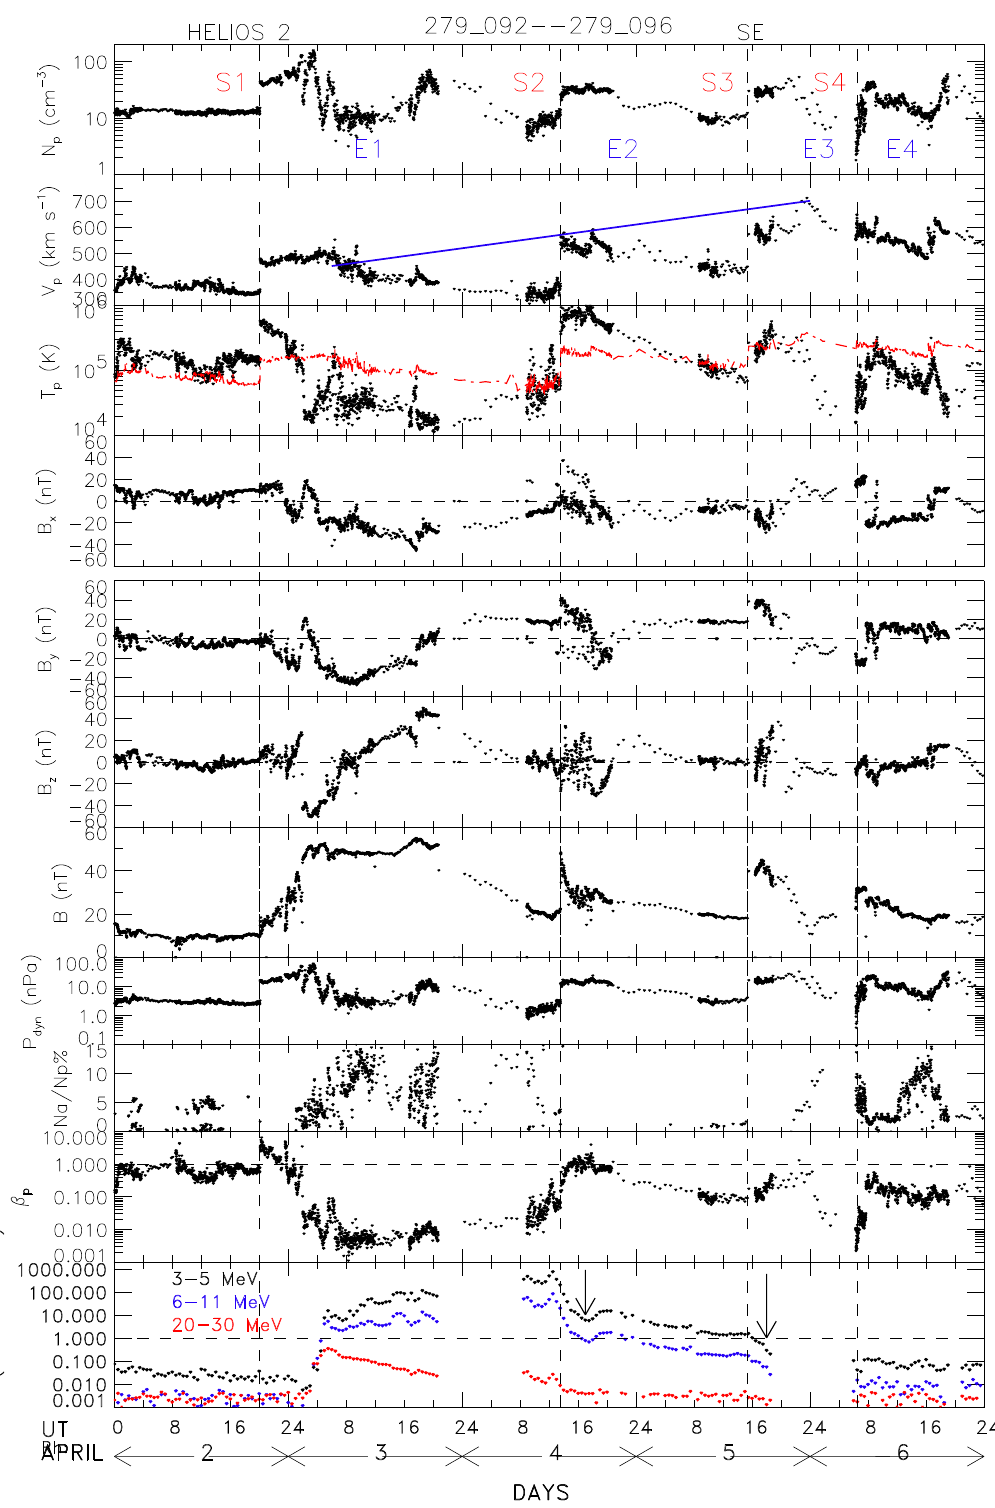
Fig. 2. Plasma, magnetic field, and energetic particle data for 2–6 April 1979. Shown from top to bottom are the proton density, bulk speed, and temperature, the components of the magnetic field in solar ecliptic (SE) coordinates, the total field strength, the dynamic pressure based on the protons, the α -to-proton number density ratio in percent, the proton beta, and the proton fluxes in the MeV energy ranges shown. The red line in panel 3 gives the expected solar wind temperature for normal solar wind expansion. The blue line in panel 2 joins the estimated mid-point of the first and third